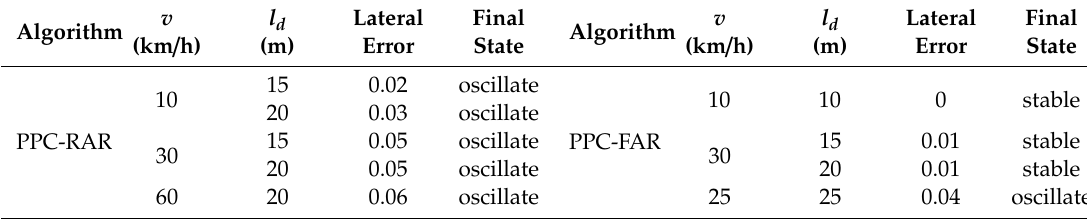
Table 4. Performances of PPC-RAR and PPC-FAR with di ff erent l d and k .